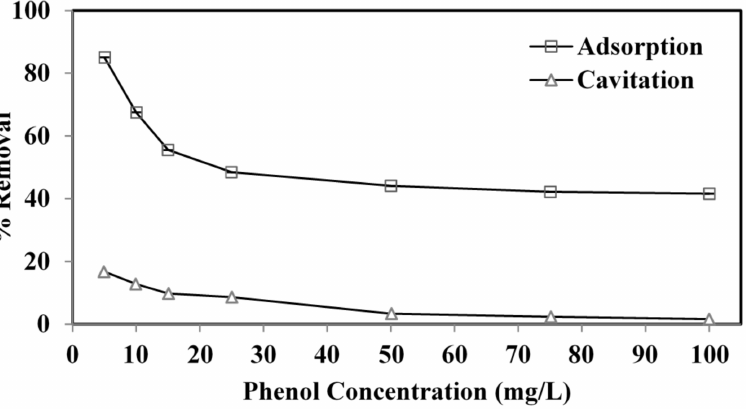
Figure 5. Effect of initial phenol concentration on removal of phenol by adsorption and cavitation processes. Experimental conditions: pH = 3.5, adsorbent dose = 800 mg L − 1 , cavitation power = 80 W, temperature = 30 ± 2 ◦ C, time = 60